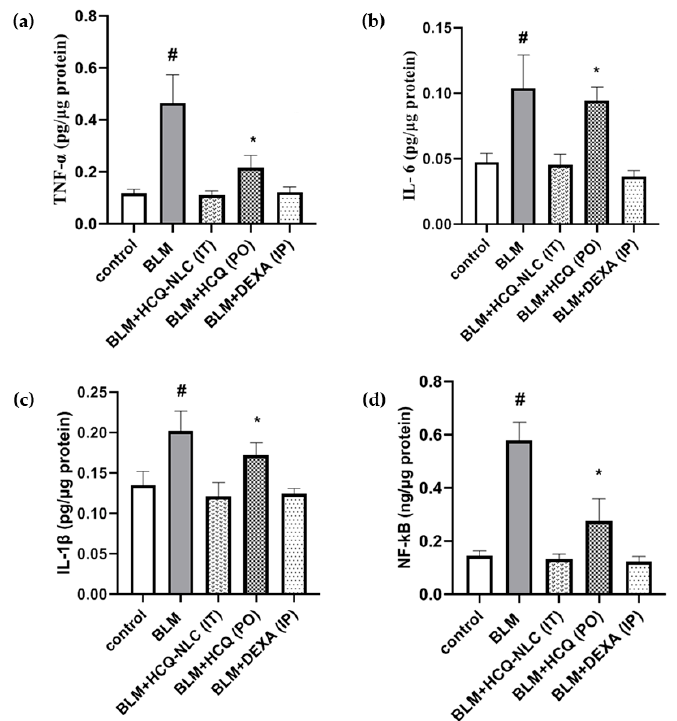
Figure 4. Effect of various HCQ formulations on the concentration of ( a ) TNF- α , ( b ) IL-6, ( c ) IL-1 β , and ( d ) NF- κ B in lung tissues. Animals were given a single dose of BLM (2.5 mg/kg) followed by, once daily, six doses of either HCQ-NLCs (8.78 mg/kg) intratracheally (IT), HCQ (70 mg/kg) orally (PO), or DEXA (5 mg/kg) intraperitoneally (IP). # Significant ( p < 0.05) versus all groups. * Significant ( p < 0.05) versus the control group and HCQ-NLC group.